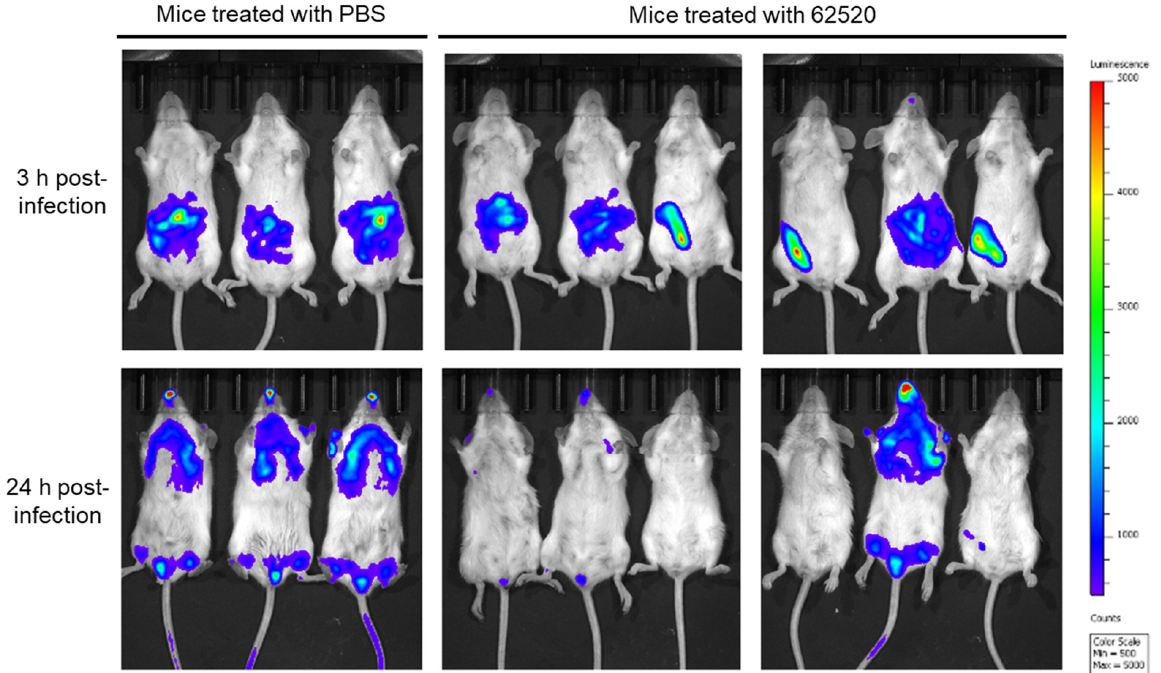
Figure 5. Bacterial clearance in mice treated with compound 62520. Immunocompetent mice were intraperitoneally infected with 1.0 × 10 9 CFUs of A. baumannii ATCC 17978-lux strain, and, 2 h after bacterial injection, 2.8 mg/kg of compound 62520 was injected in the opposite side of their abdomen. The control mice were injected with the same volume of PBS. The color bar beside IVIS images indicates the intensity of radiance (p/sec/cm 2 /sr).